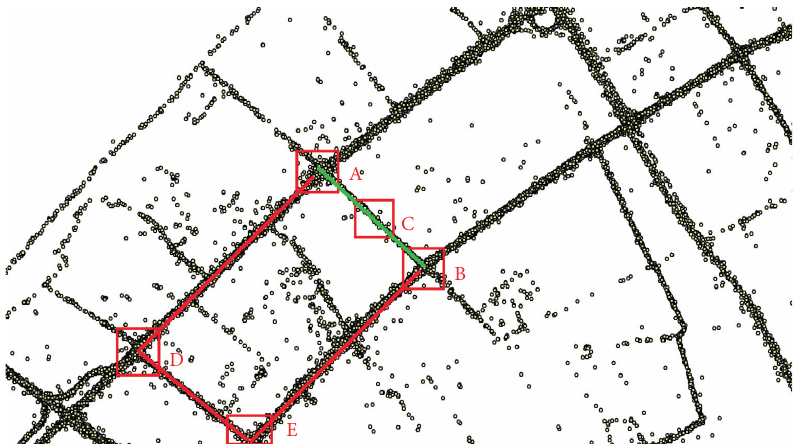
Figure 2: Method for identifying the taxi trajectory on the target road section and the calculation of travel